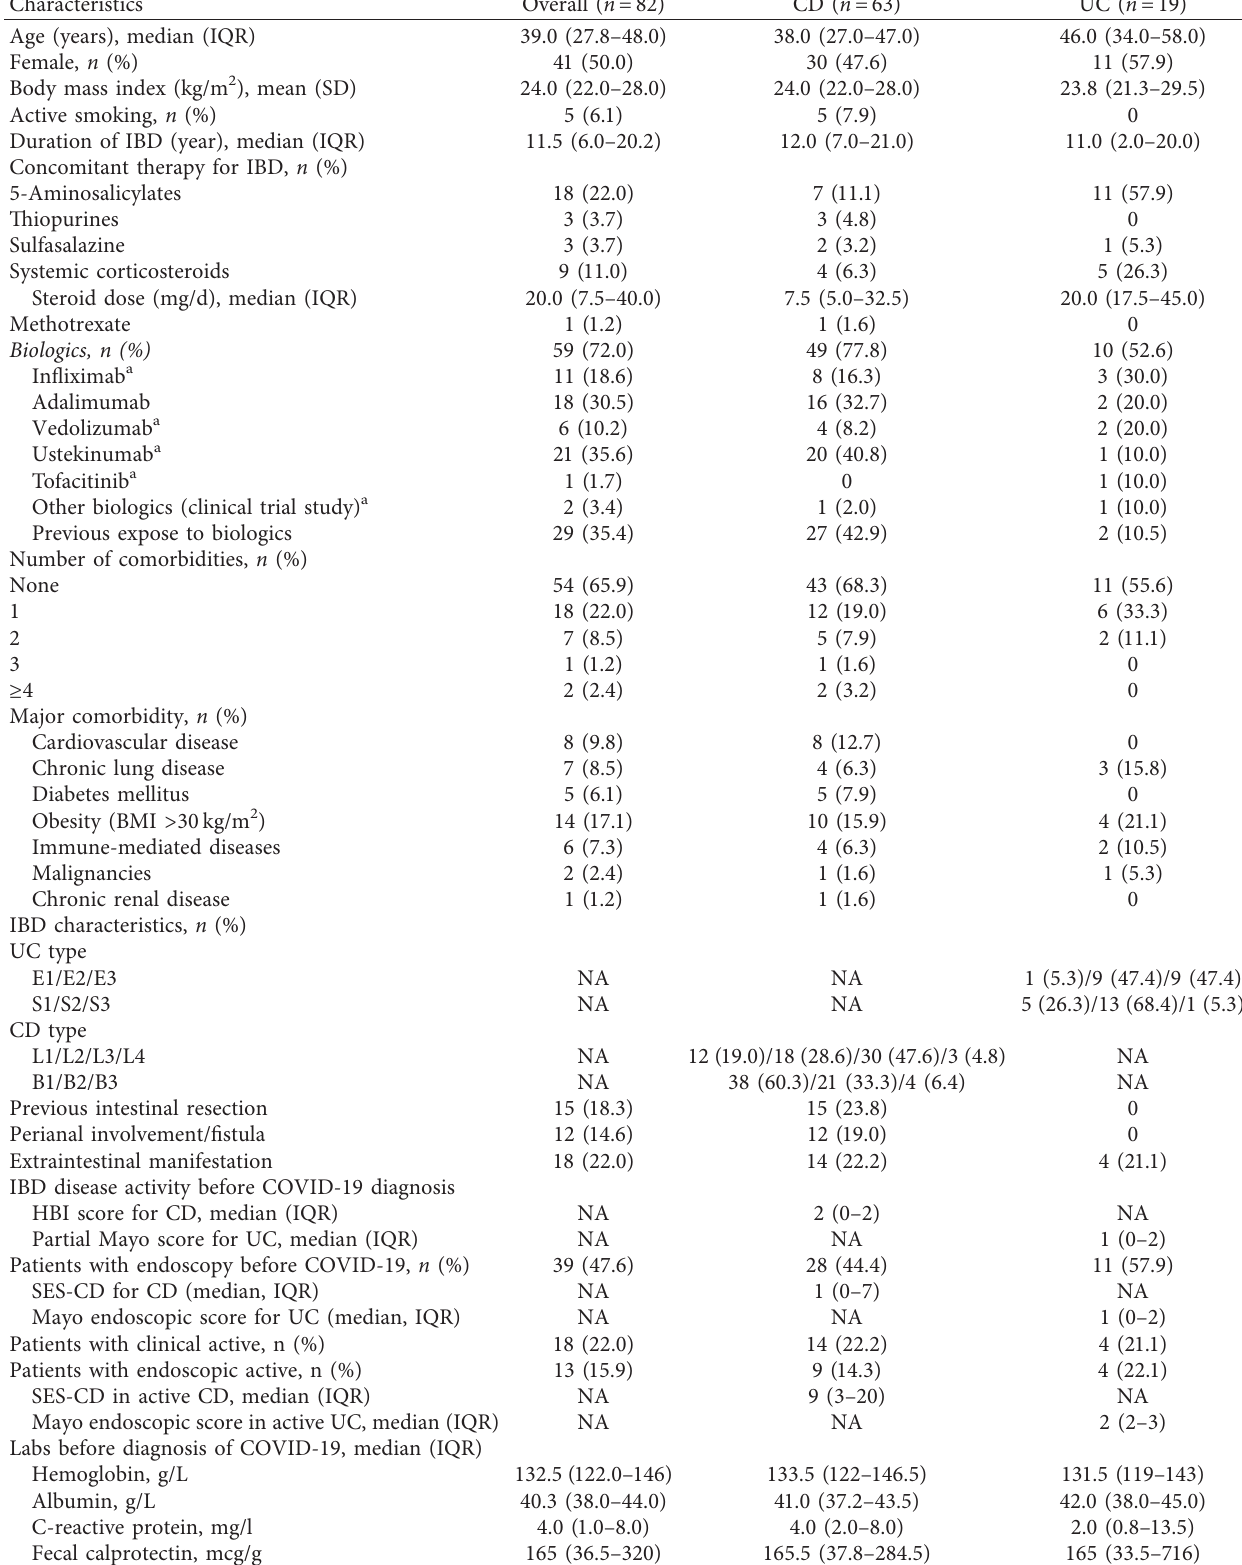
Table 1: Baseline characteristics of IBD patients with COVID-19